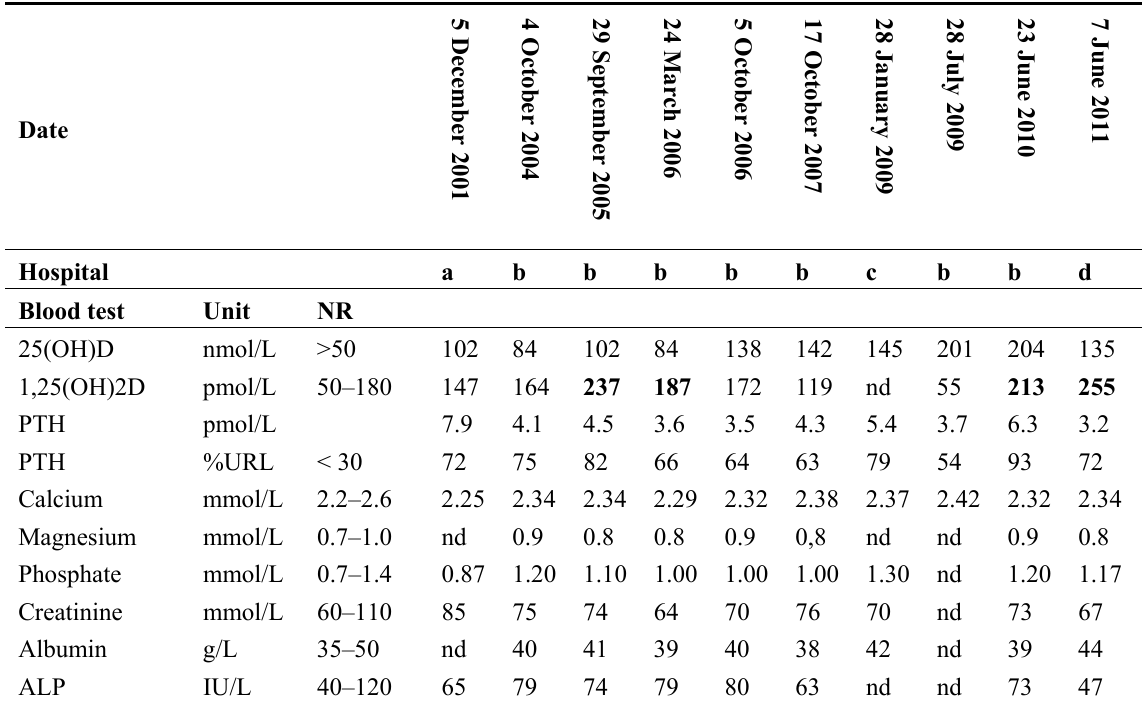
Table 1. Biochemical assessment ( n =